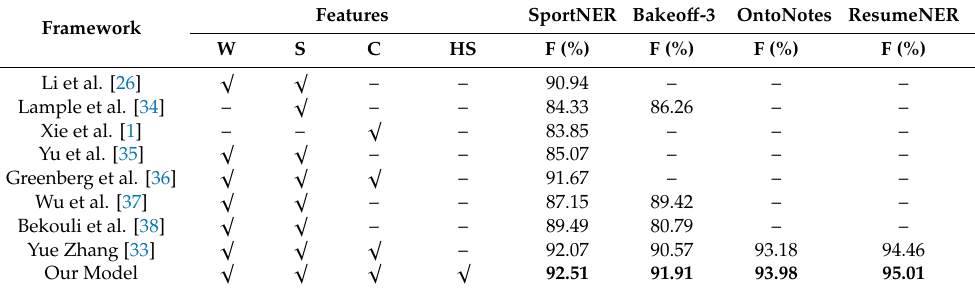
Table 7. Comparison of the proposed model with other